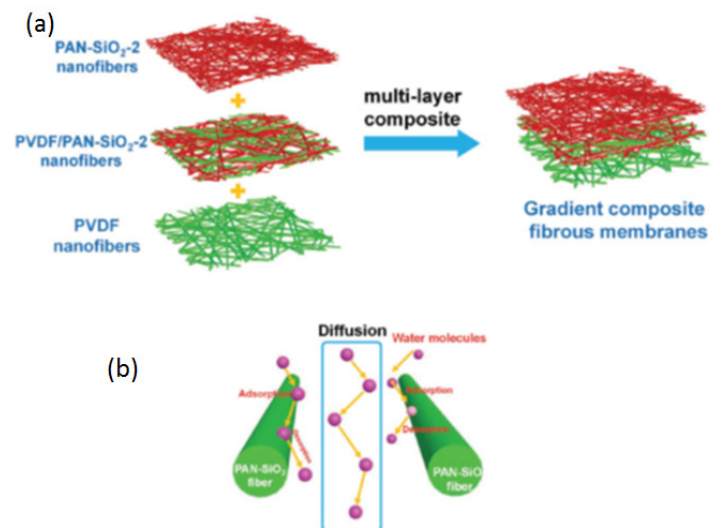
Figure 10. Schematic of the fabrication process, structure, and the interaction with the water molecules ( a ) the stacking structure of the composite air filter, ( b ) the mechanism of transferring water molecules. (Reprinted with permission from [60]. Copyright 2017 John Wiley & Sons.)